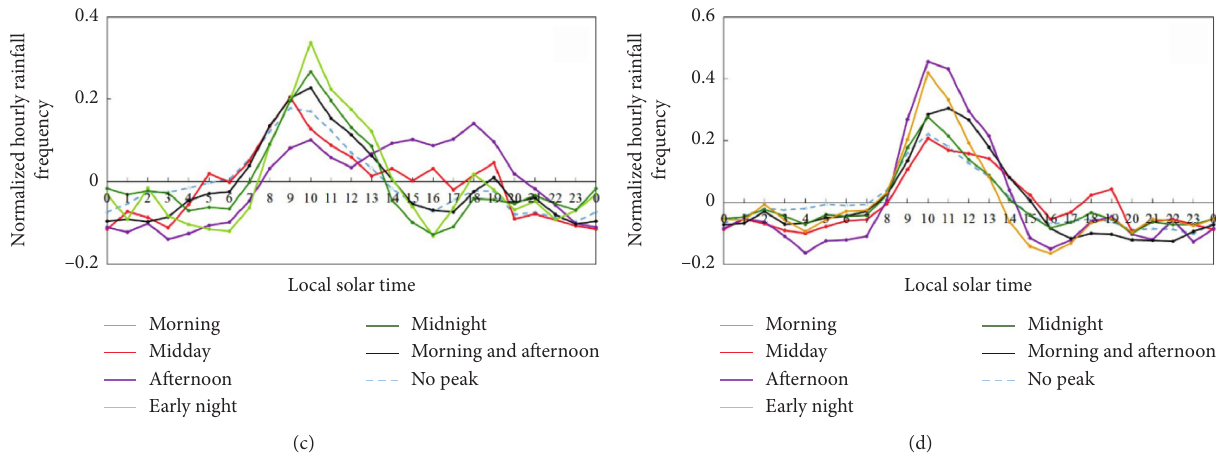
Figure 7: Curves of normalized hourly gauge precipitation frequency, calculated based on the classification of diurnal variation of precipitation in Figure 4: (a) for spring, (b) for summer, (c) for autumn, and (d) for winter.